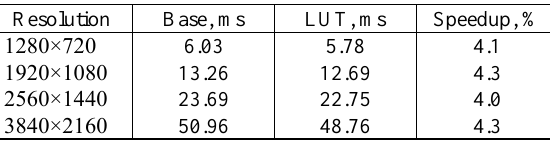
Table 4. Comparison of 2-level DWT calculation in basic method (Base) and proposed lookup table (LUT).